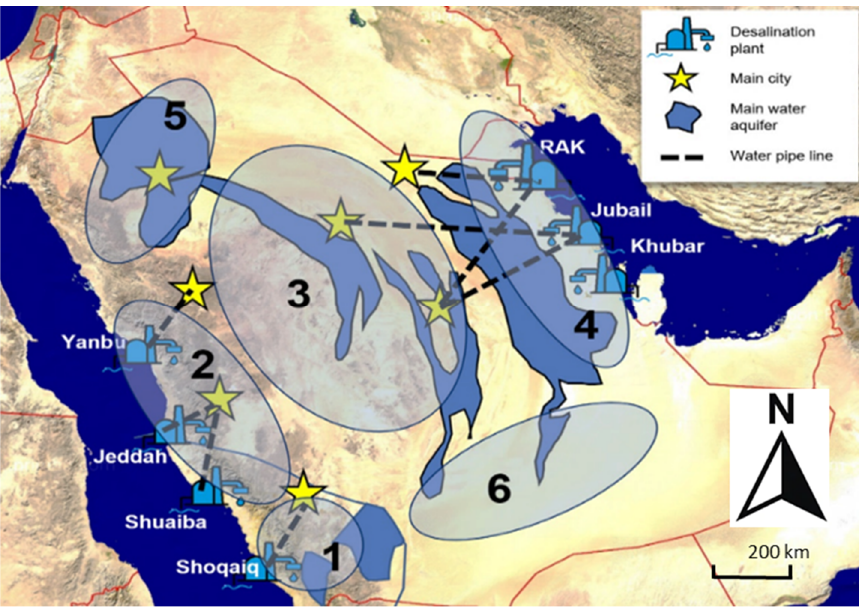
Figure 4. Water resources and main demand zones in SA.